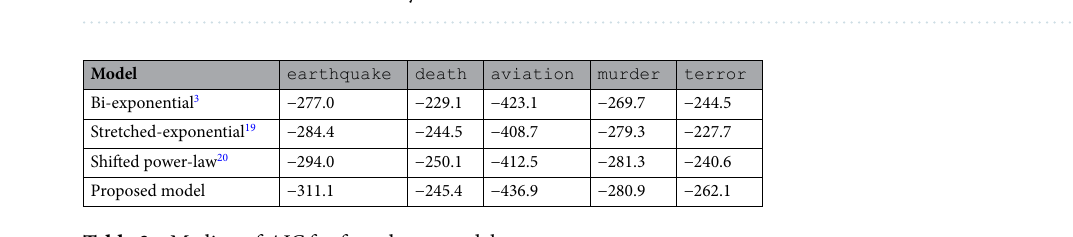
Table 2. Median of R